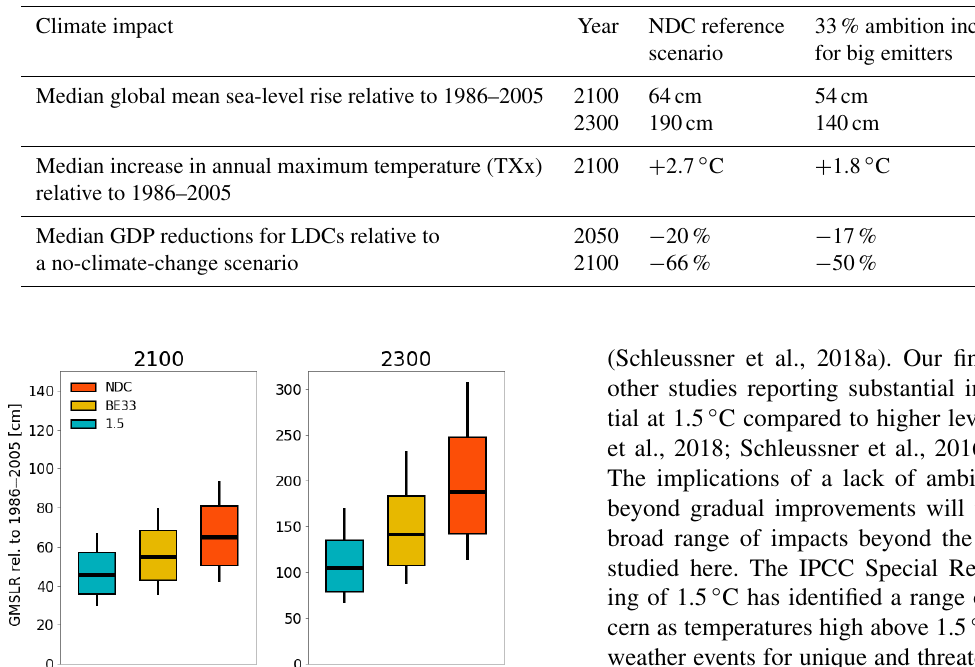
Table 2. Selected climate impacts under different scenarios of mitigation ambition: global mean sea-level rise, annual maximum temperature (TXx) increase and GDP reductions for Least Developed Countries (LDCs). For more quantitative information on uncertainties, please see Figs. 2 to 4.